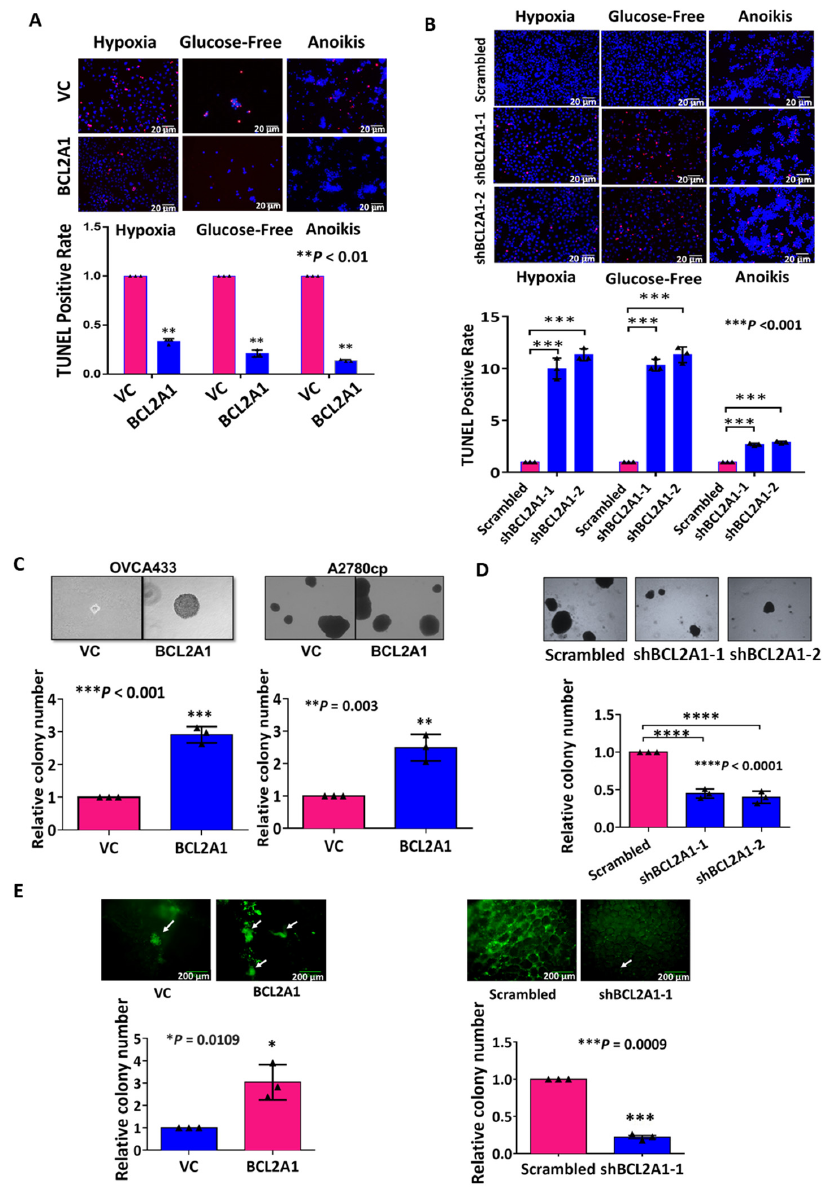
Figure 5. BCL2A1 enhances cell survival and promotes the oncogenic capacities of ovarian cancer cells. TUNEL assay ( In Situ Cell Death Detection Kit) revealed the cell apoptosis in OVCA433 cells with ( A ) BCL2A1 overexpression and ( B ) BCL2A1 knockdown cells were cultured under the condition of hypoxia treatment (0.5% O 2 ), glucose-fee and anoikis assay for 24–30 h. Images were taken at a mag- nification of 40×. Scale bar: 20 μ m.The bar charts show the normalized TUNEL positive rates (** p < 0.01). VC = empty vector control. ( C ) Soft agar assay showed the anchorage-independent growth ability in BCL2A1 stably overexpressing cells of OVCA433 (*** p <0.001) and A2780cp (** p = 0.003). The bar chart showed the relative colony numbers in BCL2A1 overexpressing cells, which was cal- culated by normalizing the number of the colony of the empty vector control (VC) of each cell line. ( D ) Soft agar assay showed the anchorage-independent growth ability in BCL2A1 knockdown clones (A2780cp-shBCL2A1-1 and A2780cp-shBCL2A1-2) and scrambled control cells (A2780cp- Scrambled (**** p < 0.0001). ( E ) The ex vivo omenta-tumor colonization model showed that the tumor colonization patterns in BCL2A1 stably overexpression clone (BCL2A1) with its empty vector con- trol cells (VC) of GFP-labeled ES-2 cells co-cultured with mice omenta (* p = 0.011), and in BCL2A1